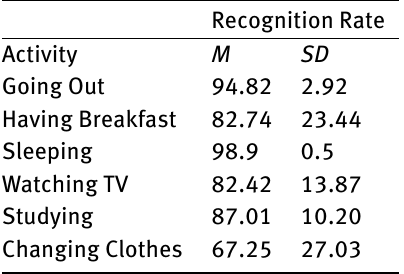
Table 6: Leave-one-out methodology (ARAS